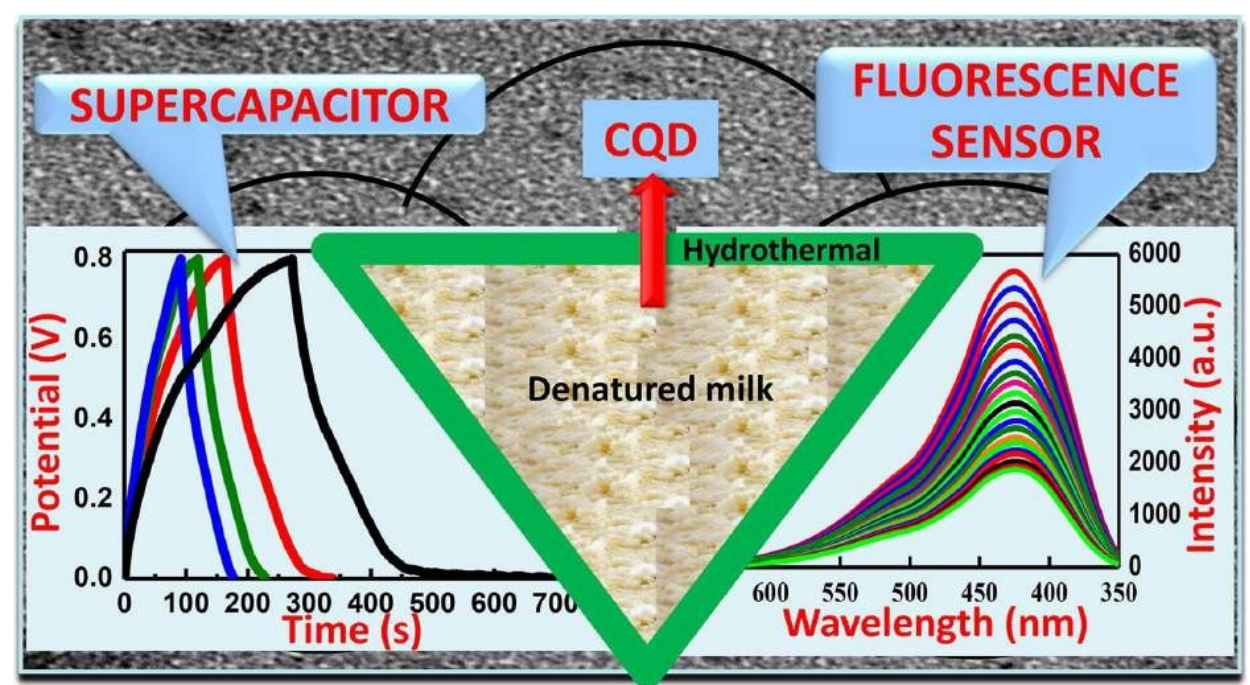
Figure 4. Denatured milk carbon quantum dots for effective chromium-ion detection and superca- pacitor applications [52].